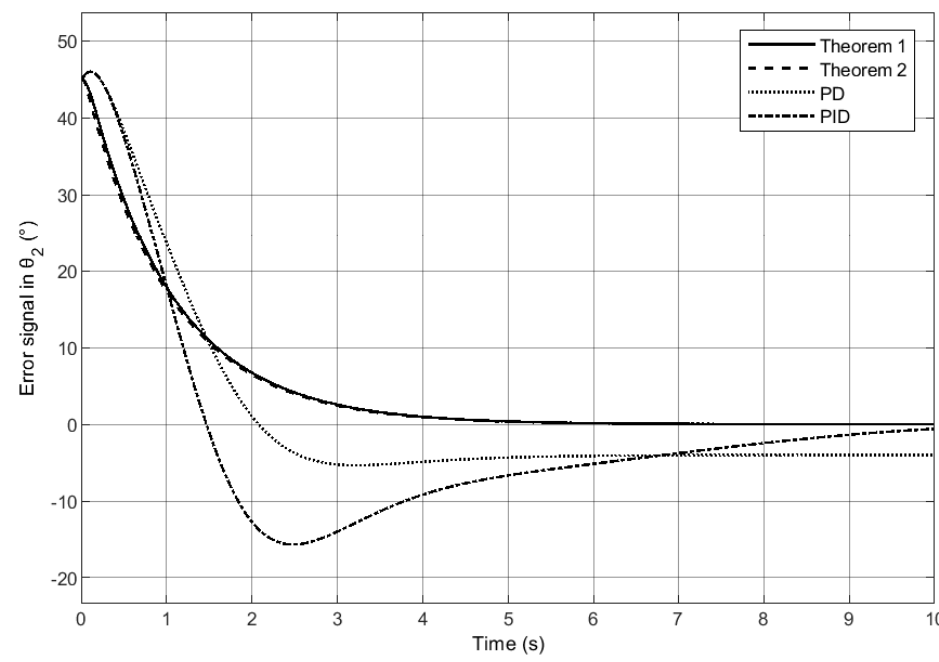
Figure 5. Error signals with diverse controllers in θ 2 for a two degrees-of-freedom